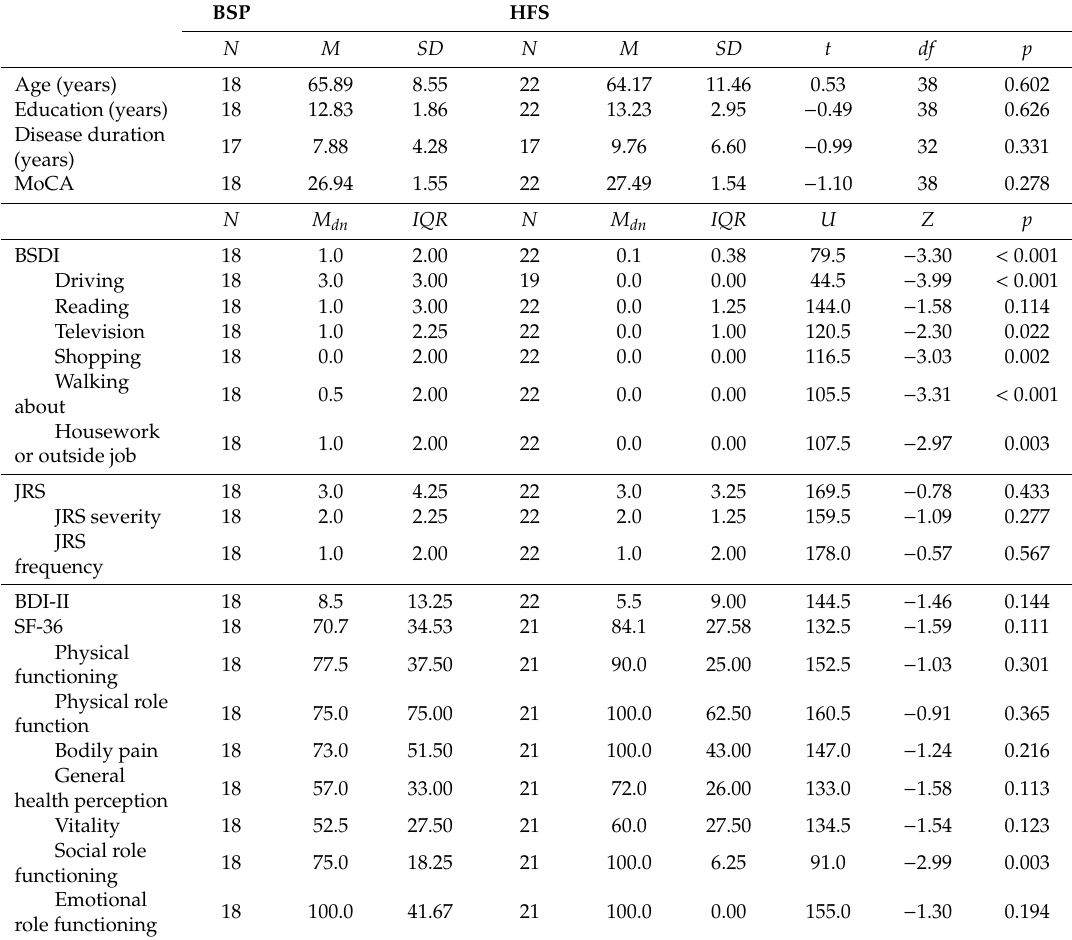
Table 1. Sociodemographic data and group